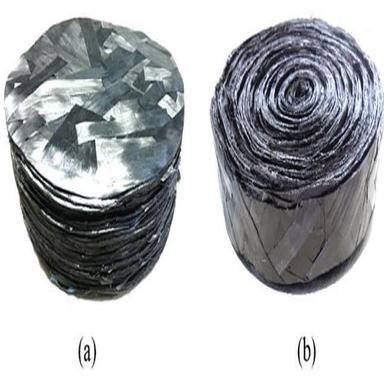
a) ASMC stacked with fiber orientation parallel to the platform interface; b) ASMC stacked with fiber orientation orthogonal to the platform interface.